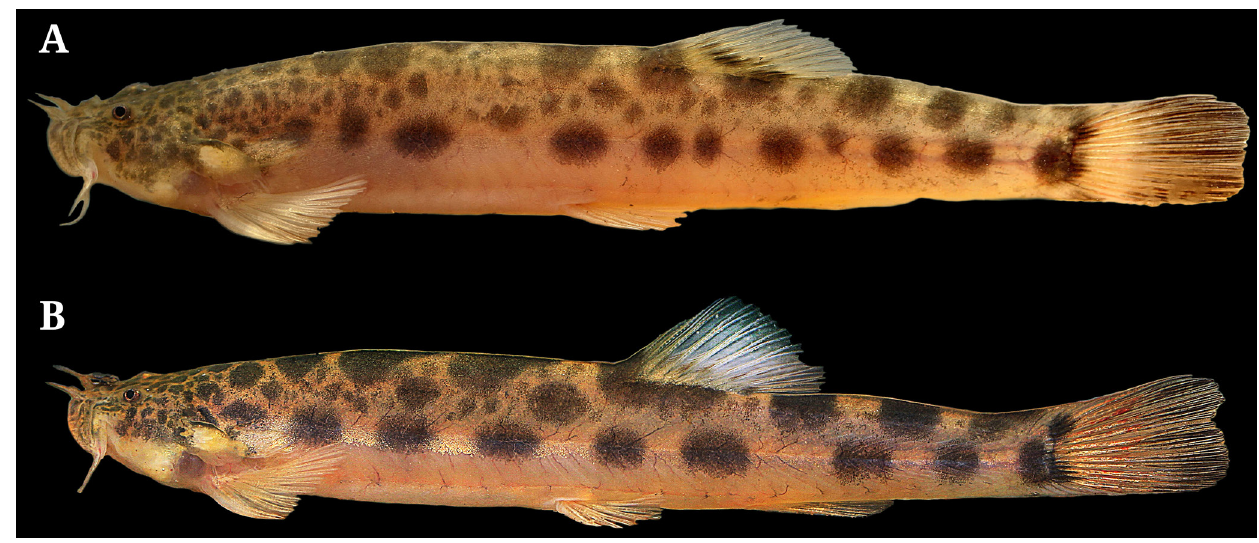
FIGURE 11 | Specimens in life of Scleronema macanuda , new species, paratypes, (UFRGS 21635; A. 75.6 mm SL, B. 65.7 mm SL), Brazil, Rio Grande do Sul, Bagé, rio Piraí, tributary of rio Negro, lower rio